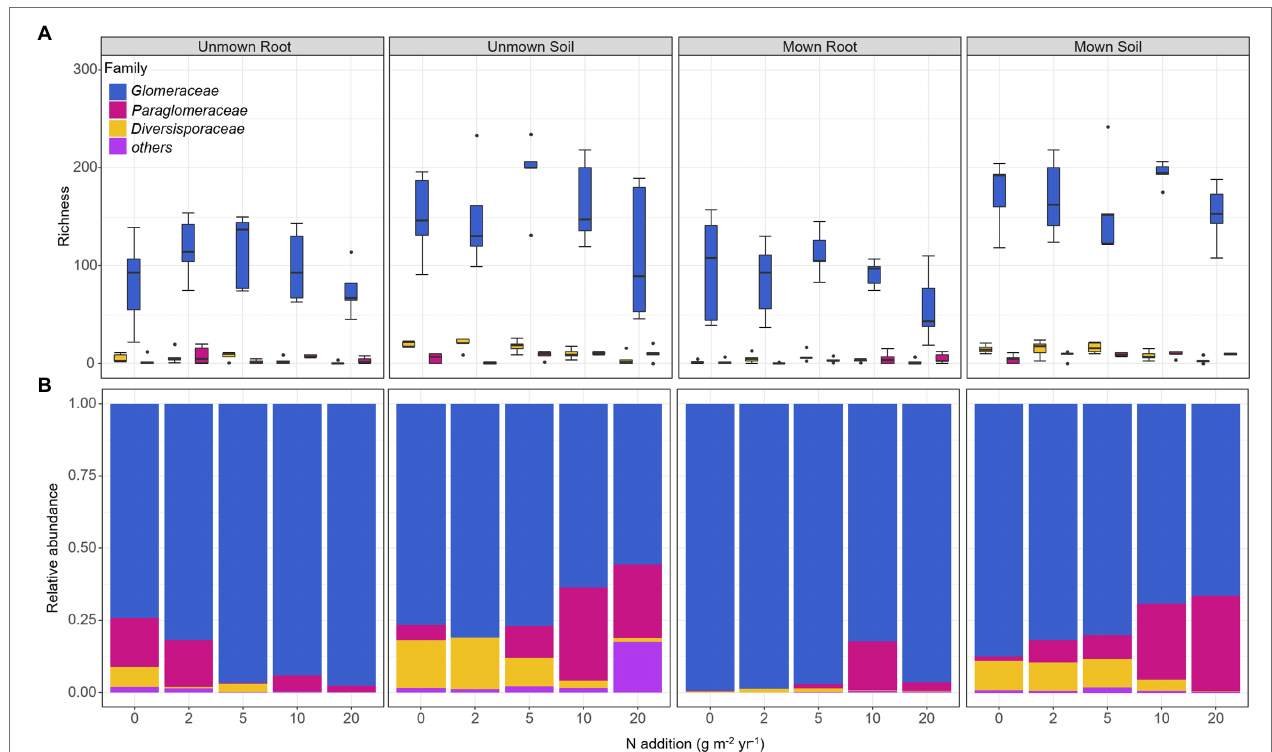
FIGURE 3 | Effects of nitrogen addition and mowing on the richness and relative abundance of AM fungal dominant families. (A) Richness of AM fungal dominant families and (B) relative abundance of AM fungal dominant families. The mid-horizontal lines within boxplots represent the median. 0, 2, 5, 10, and 20 denote